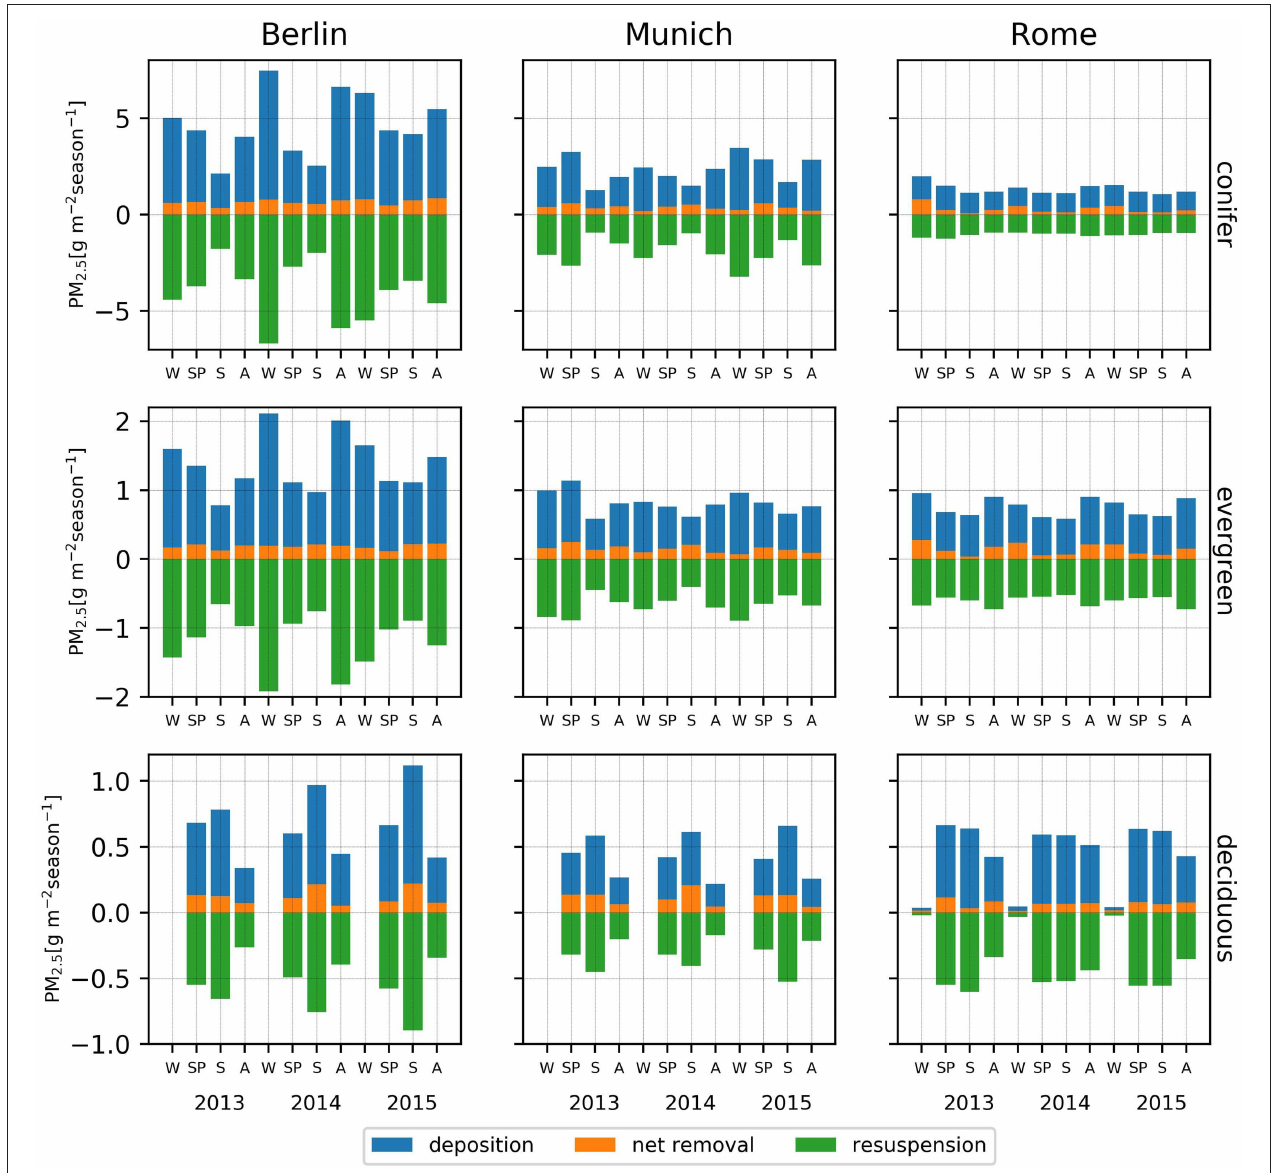
FIGURE 3 | Seasonal PM 2.5 deposition, removal, and resuspension for three cities, 2013–2015 [seasons: W, winter; SP, spring; S, summer; A, autumn].